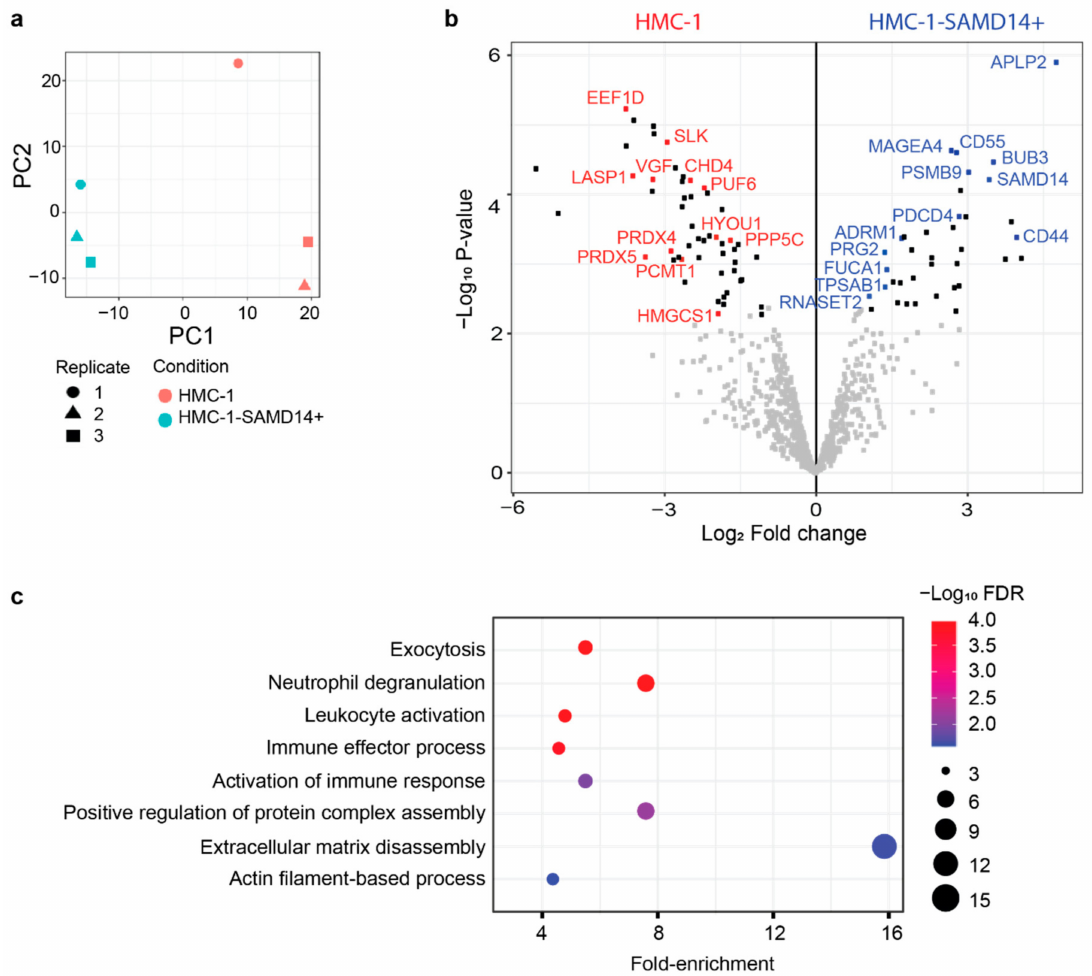
Figure 3. Proteomic analysis of secreted proteins in HMC-1 CM and HMC-1-SAMD14+ CM. ( a ) PCA plot of HMC-1 (red) and HMC-1-SAMD14+ (blue) CM based on secreted protein analysis. For each condition, the experiment was repeated 3 times (circle, triangle, and square). ( b ) Volcano plot visualization of the differentially secreted proteins between HMC-1 (red) and HMC-1-SAMD14+ (blue) based on FDR < 0.05 cutoff (black). ( c ) Functional analysis of the secreted proteins in HMC-1-SAMD14+ CM compared to HMC-1 CM. The plot shows the functional categories that are over-represented in HMC-1-SAMD14+ CM relative to HMC-1 CM using a permutation-based false discovery rate (FDR)